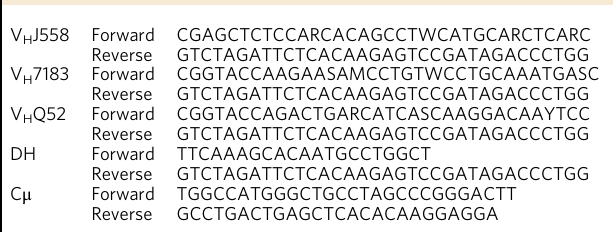
Table 2 List of primers used to amplify immunoglobulin